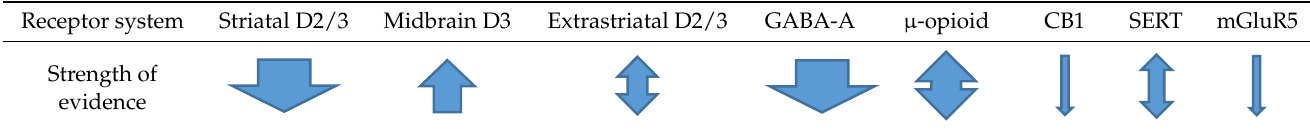
Table 1. Strength of evidence to show direction of effects on receptor radioligand binding in human PET imaging studies in alcohol dependence.